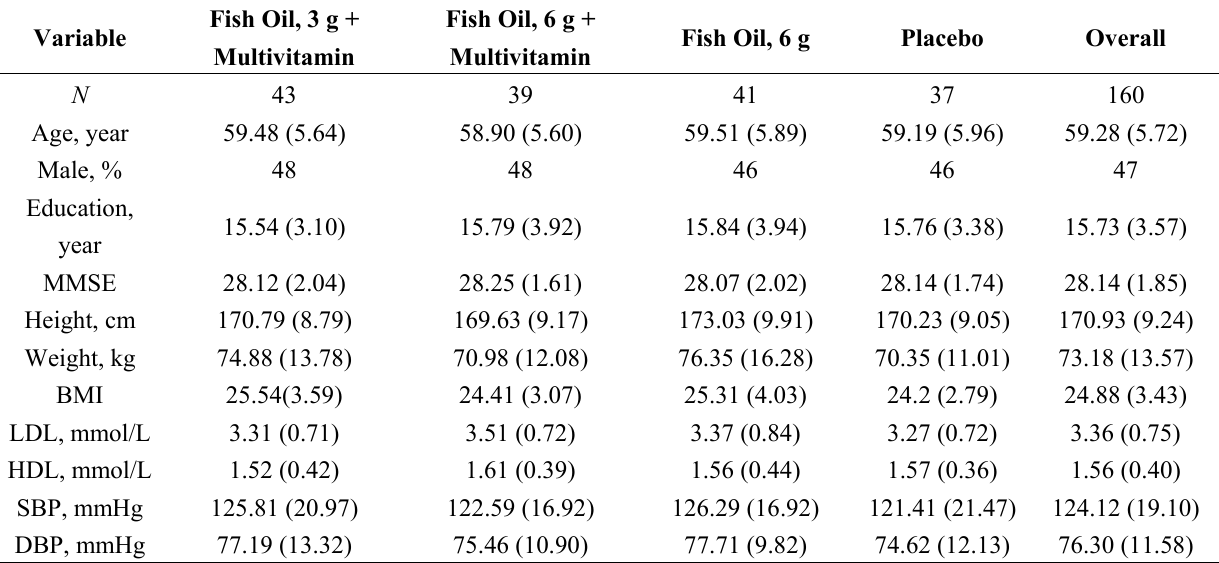
Table 1. Sample demographics (means and standard deviations) stratified by treatment